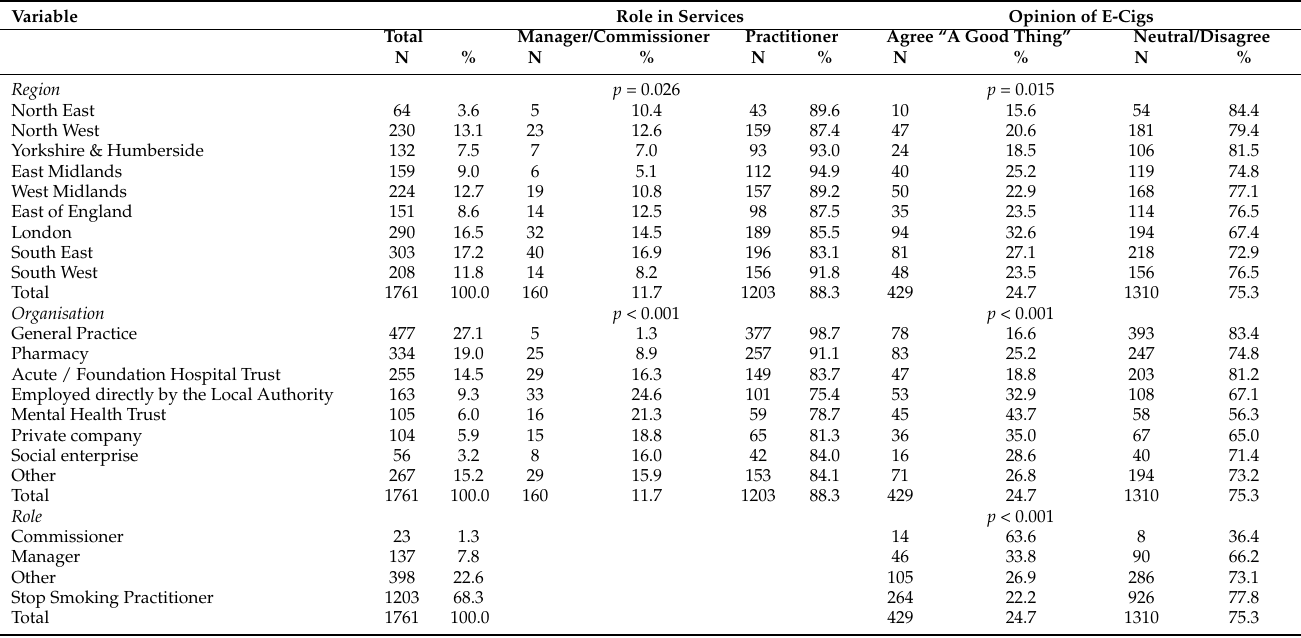
Table 3. Stances of service providers on